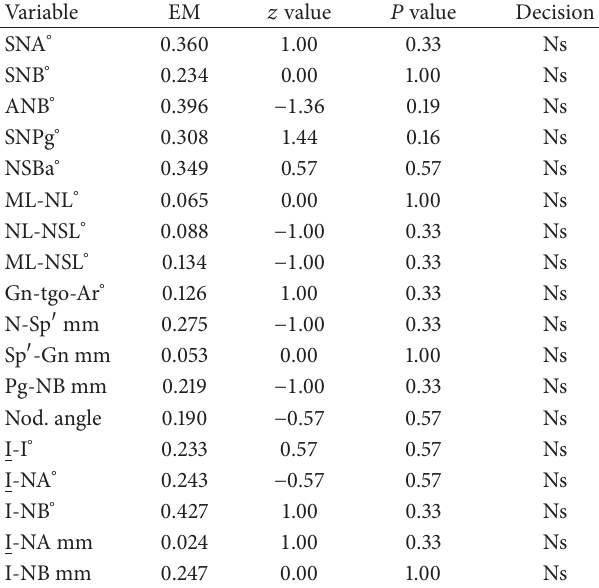
Table1:ReliabilityofmeasurementsusingreliabilityStudent’s 𝑡 -test.